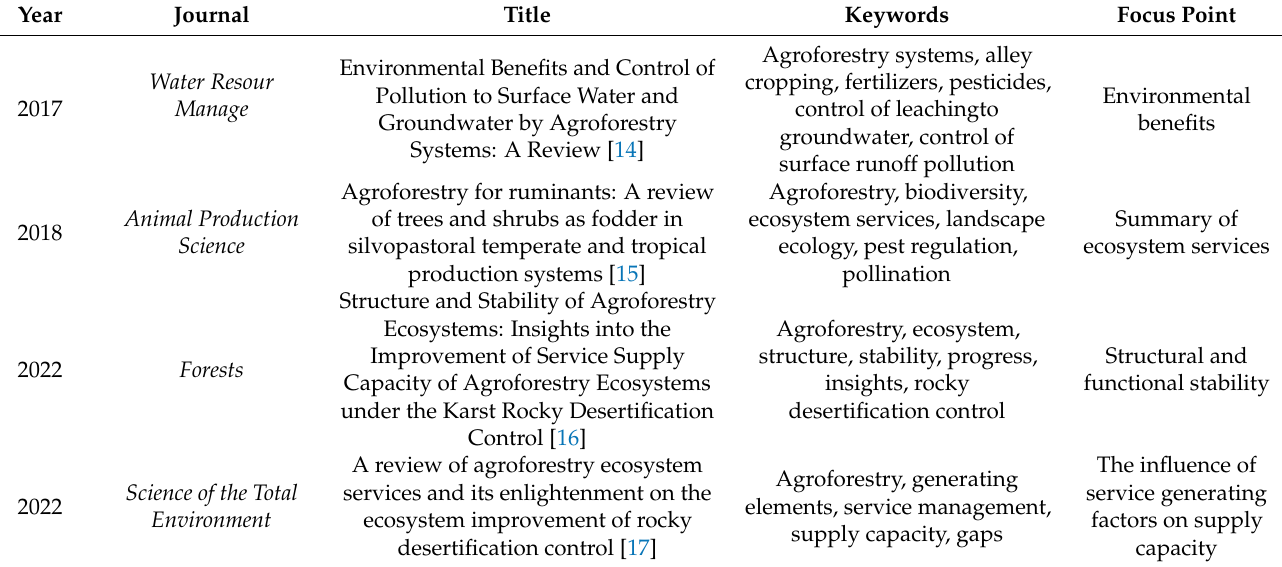
Table 1. Comparison of existing review papers with this